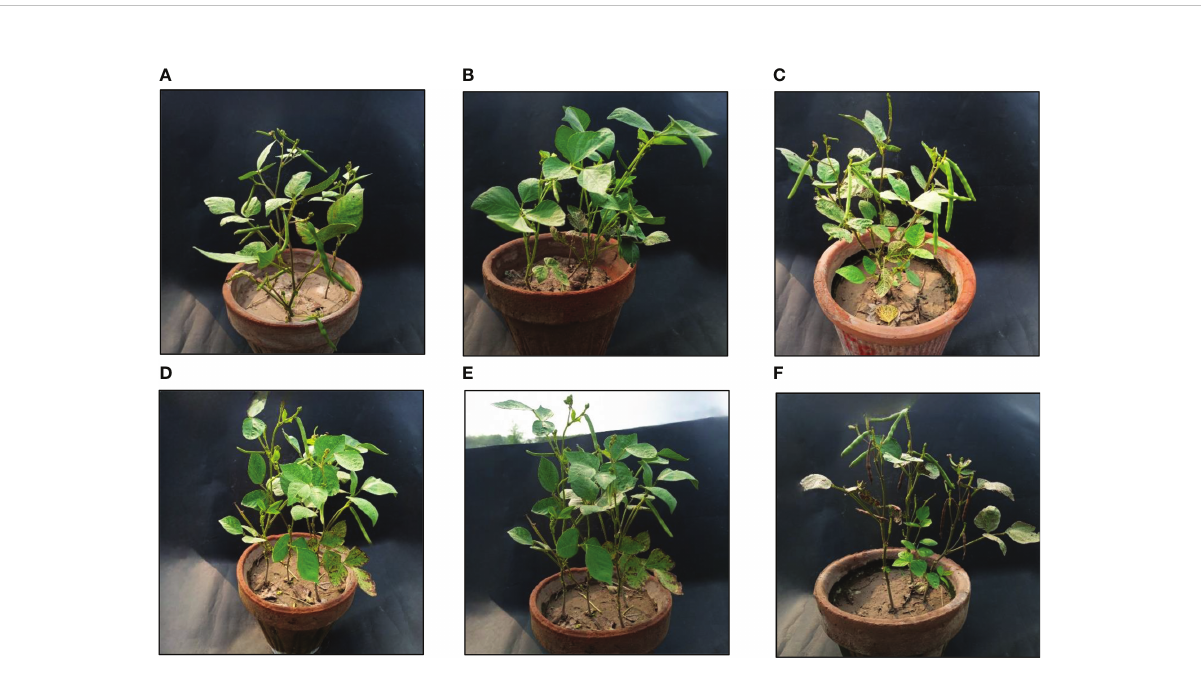
FIGURE 8 Effects of different GO NPs treatments on mungbean plants at harvesting stage. (A) = C= without GO NPs application (control); (B) = T1= 300 mg/L; (C) = T2= 600 mg/L; (D) = T3= 900 mg/L; (E) = T4= 1200 mg/L; (F) = T5= 1500